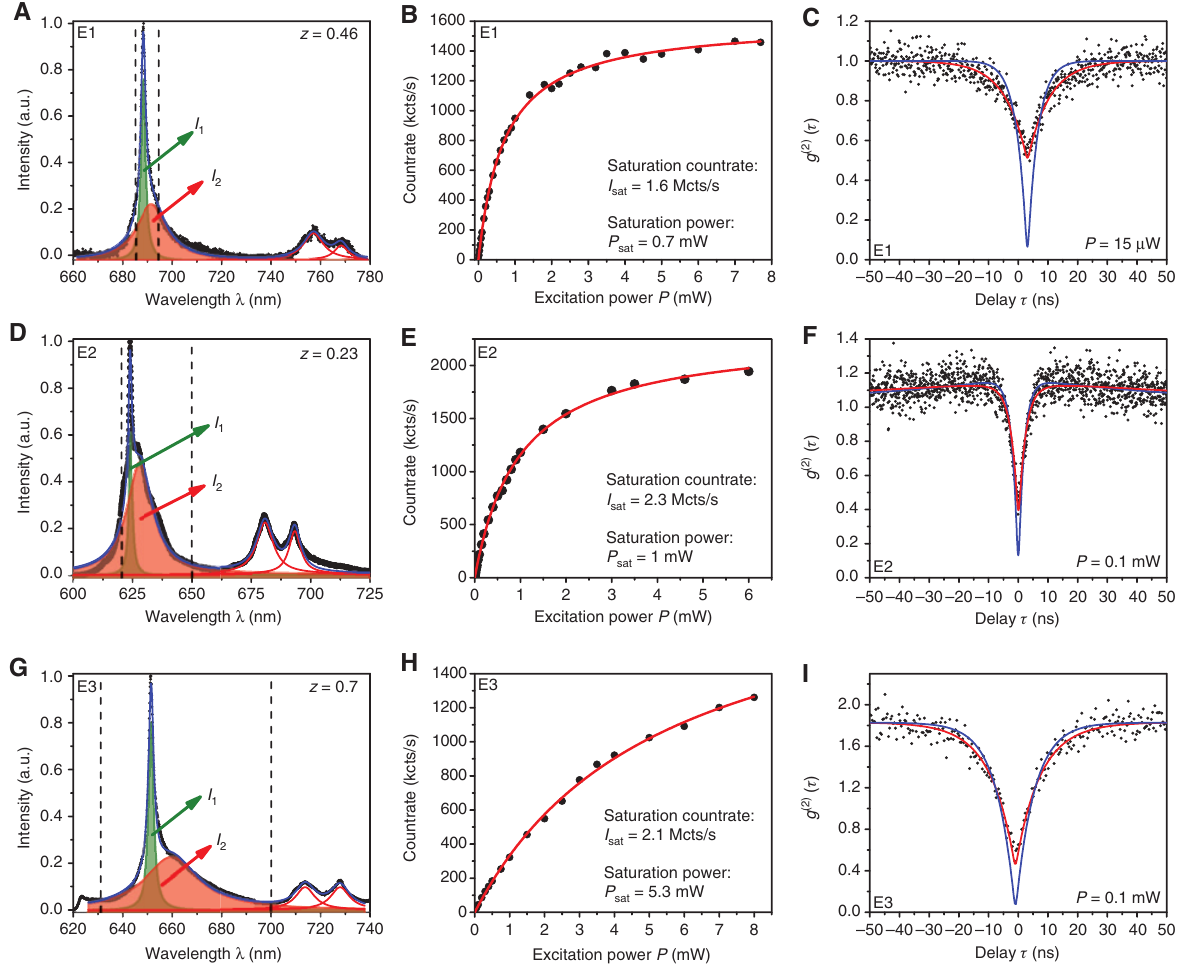
Figure 1: Photoluminescence spectra and single photon emission from individual defects in hBN. (A, D, G) Typical spectra of three defects (E1, E2 and E3) in hBN consisting of four Lorentzian lines; (B, E, F) Saturation measurements on the defects from A, D and G with no significant background contribution; (C, F, I) g (2) -intensity correlation measurements on the defects shown in A, D and G. Photons are collected from the spectral regions enclosed in dashed lines in A, D and G, respectively. See main text for